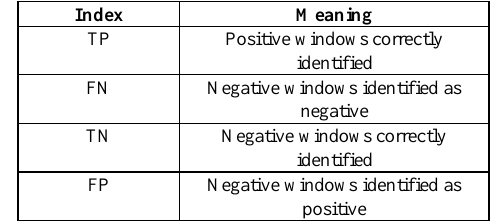
Table 1. Meaning of indexes